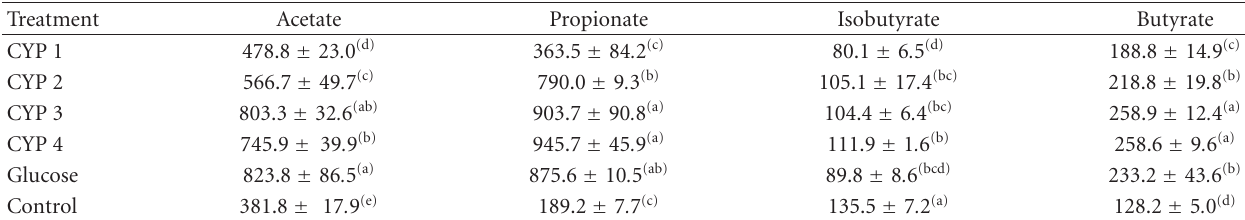
Table 5: Contents of short-chain fatty acids in fermentation broth ( µ mol/100mL ; n = 4). Treatment